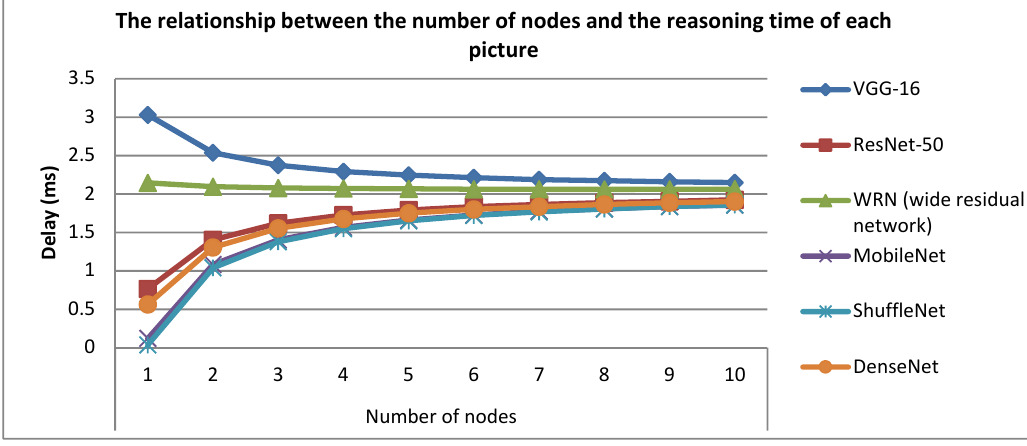
Figure 10. The relationship between the number of nodes and the reasoning time of each picture.